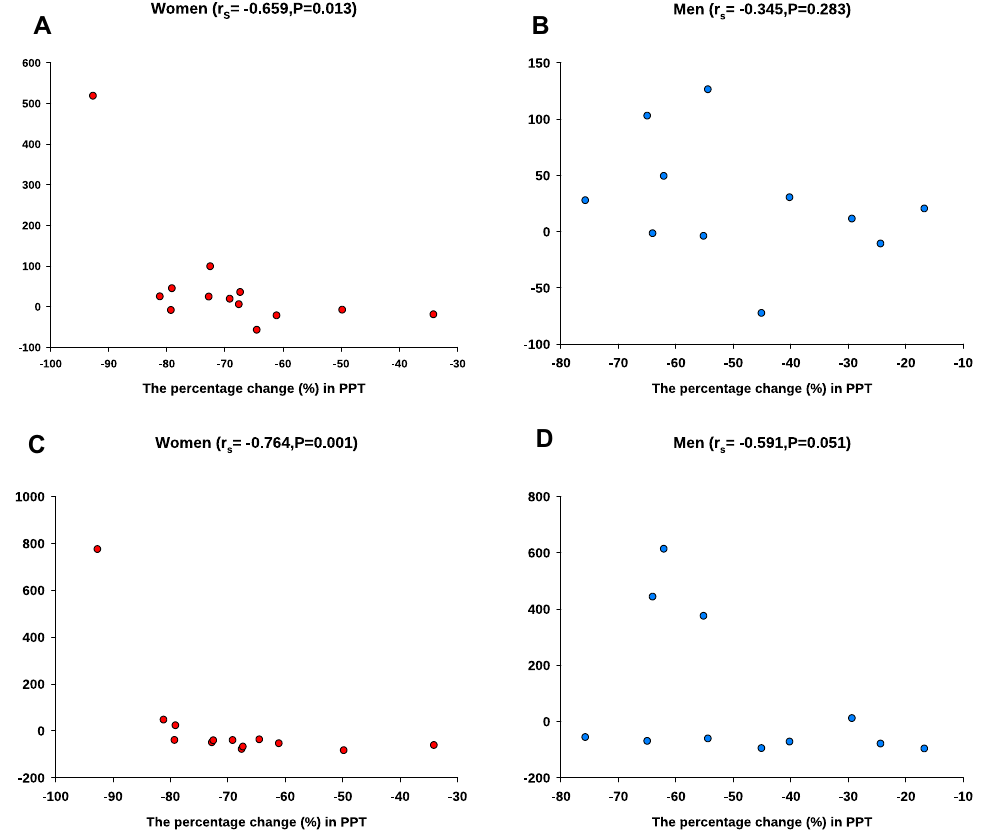
Figure 4. Graphs are illustrating the correlations between the percentage change in sensitization and the expression frequency of nerve fibers within connective tissue. The correlation between the percentage change (from day 0 to day 10) of pressure pain threshold (PPT) and the change (from day 0 to day 10) in the frequency of positive fibers within the connective tissue expressing ( A , B ) NMDA-receptor 2B alone and ( C , D ) NMDA- receptor 2B in combination with nerve growth factor (NGF) for women (n = 15) and age-matched men (n =